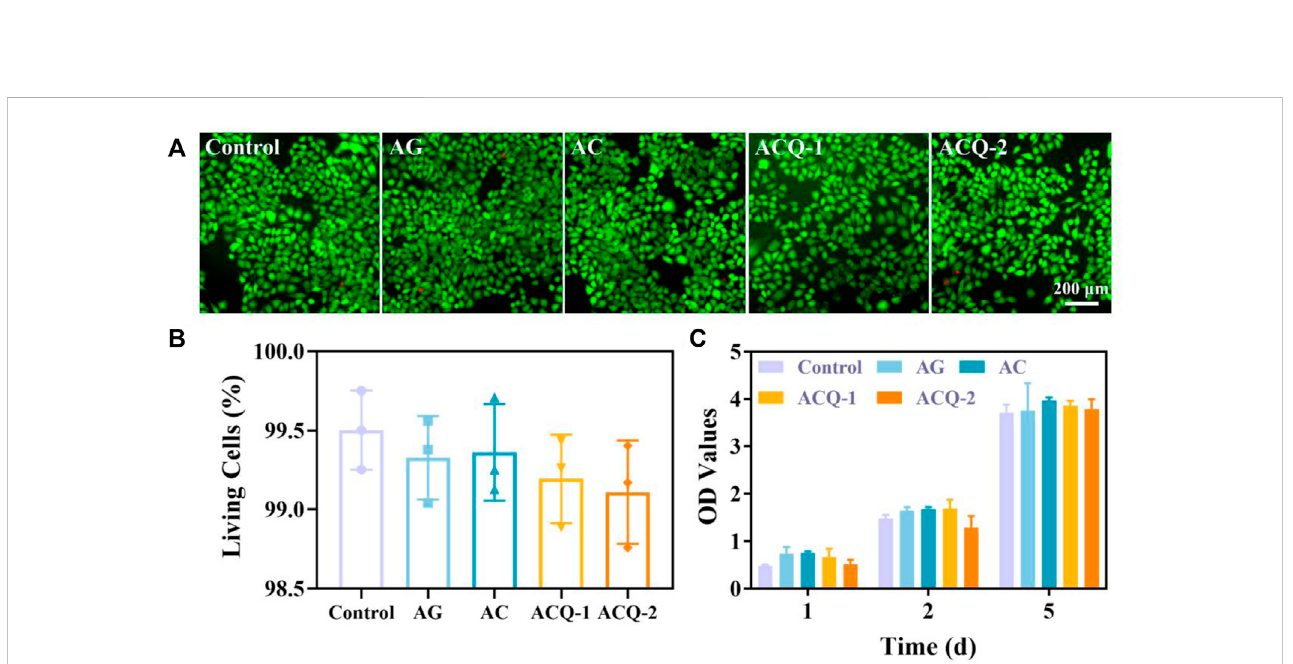
FIGURE 4 (A) Fluorescent images of cell live/dead staining of fi broblasts, and (B) the rate of living cells after co-cultivation with various sponges for 24 h, respectively. (C) The cytotoxicity of sponges after incubation with L929 cells for 1 – 5 days. Data are mean ± SD (n =